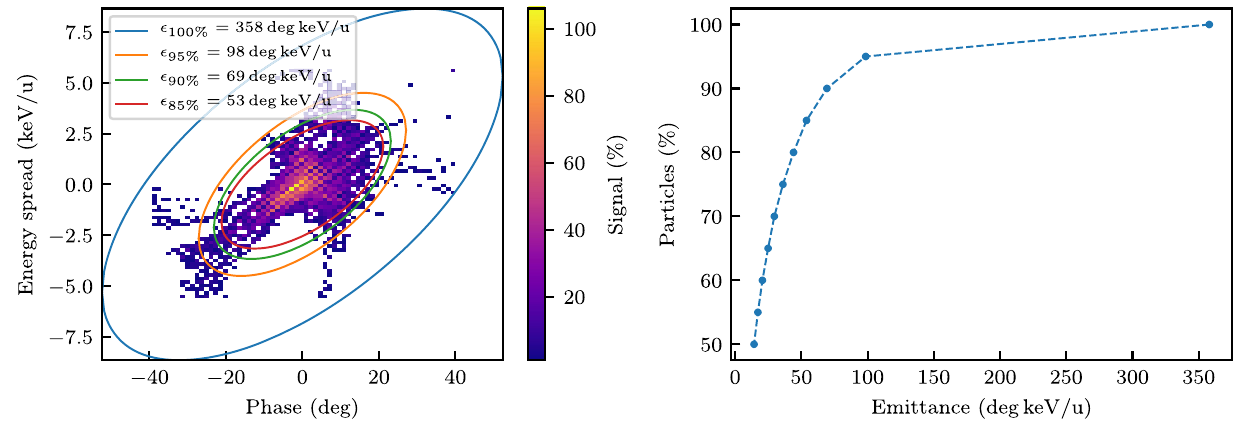
FIG. 6. Brilliance analysis of the reconstructed distribution. (a) Samples of the fitted ellipses around a fraction of the density distribution. (b) Relation of the emittance on the fraction of